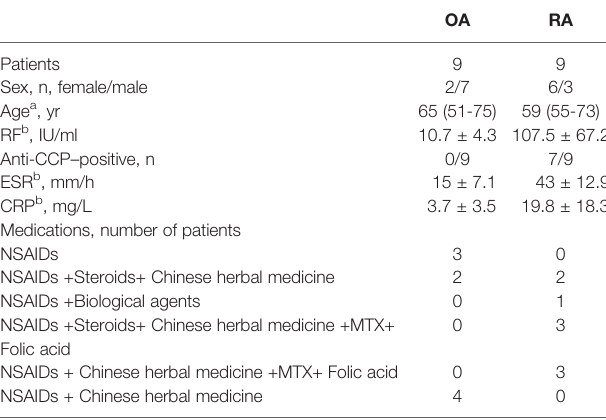
TABLE 1 | Patient